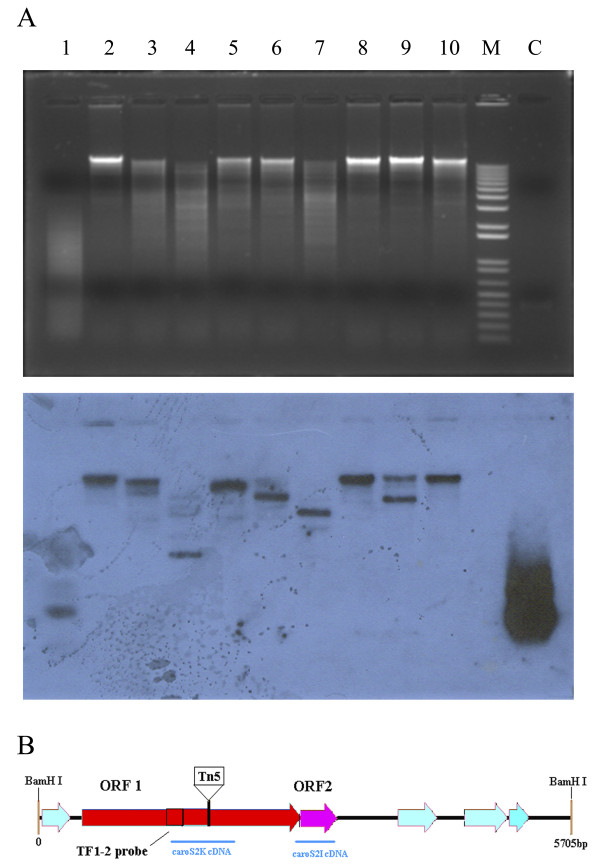
DNA library screening and scheme of carocin S2 gene. (A) The TF1-2 probe was used to screen DNA fragments from the genomic DNA library of F-rif-18. The DNA was digested with various restriction enzymes as follows: 1. Hpy188I; 2. HindIII; 3 HpaI; 4. EcoRV; 5. EcoRI; 6. ClaI; 7. BsaAI; 8. BglII; 9. BamHI; 10. AhdI; M. DNA leader marker; C. The TF1-2 probe DNA. The arrowhead indicates the 5.7-kb carocin S2 fragment. (B) Shown is the 5.7-kb segment of DNA containing the carocin S2. The location of TF1-2 probe and part amplicon of cDNA of caroS2K and caroS2I were shown.